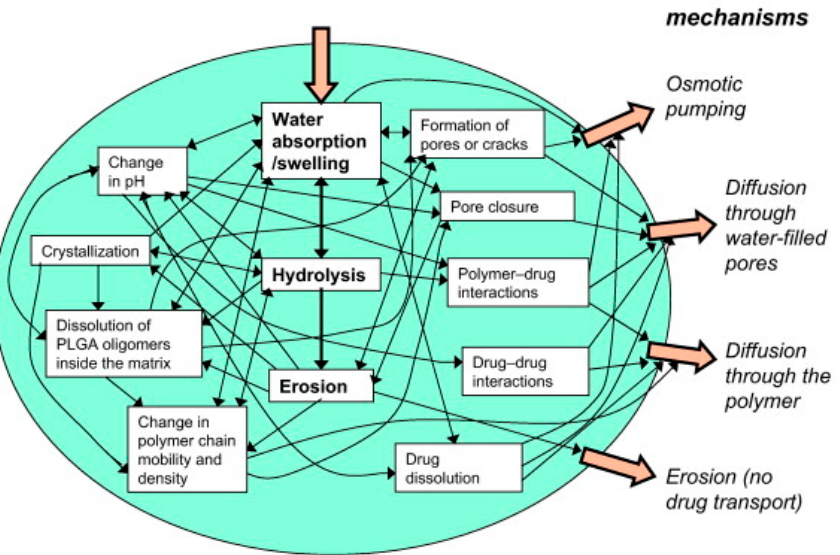
Figure 6. The complex picture of the different factors that influence drug release from PLGA matrices. Arrows illustrate the effects of the properties of the DDS and the surrounding environment on the processes that, in turn, influence drug release. Reprinted with permission from Fredenberg et al. (2011) [479]. Copyright 2021 Elsevier.